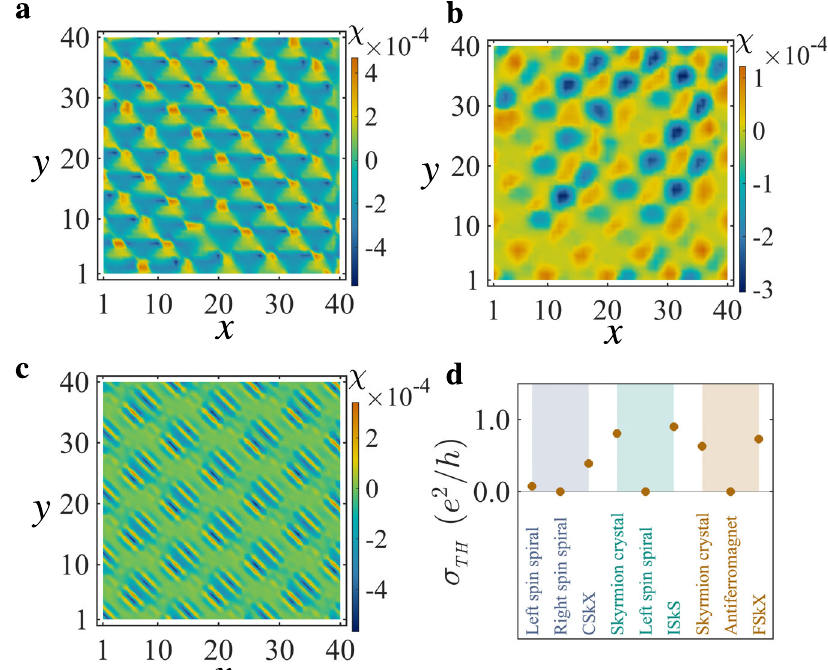
Fig. 5 Topological Hall effect. Real-space pro fi le of the scalar spin chirality χ ( r i ) for the three IPF-stabilized textures that appear in our MC simulations at the central layer of the considered multilayer: a checkerboard skyrmion crystal (CSkX), b incommensurate skyrmion stripe (ISkS), and c ferrimagnetic skyrmion crystal (FSkX). d Comparison of the topological Hall conductivity σ phases and the constituent competing